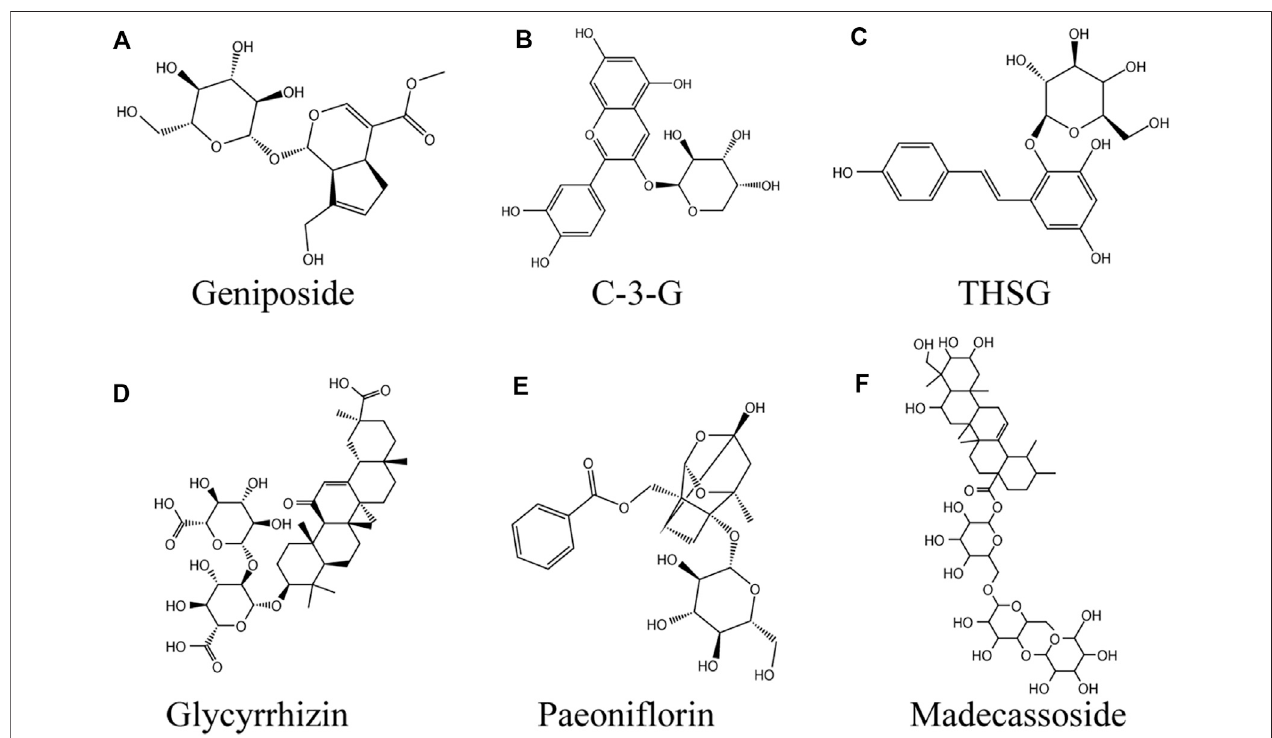
FIGURE 5 | Glycosides against vitiligo (A) Geniposide, (B) C-3-G, (C) THSG, (D) Glycyrrhizin, (E) Paeoni fl orin, (F) Madecassoside.